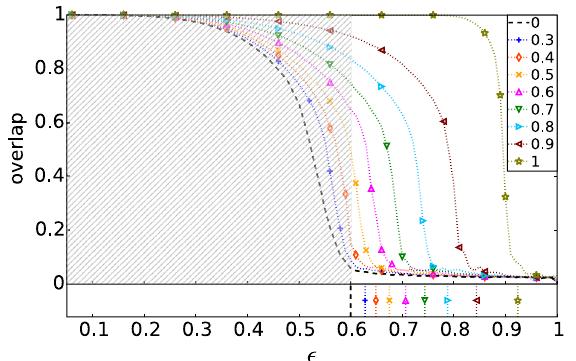
FIG. 2. Overlap as a function of ϵ for different values of η (given in the legend). For each η , the critical value of ϵ for T ¼ 40 is shown as a vertical line in the lower panel, and the hatched area shows the region of detectability for static networks [14,15]. Each data point is the average of 100 instances, with n ¼ 512 , T ¼ 40 , k ¼ 2 groups, and average degree c ¼ 16